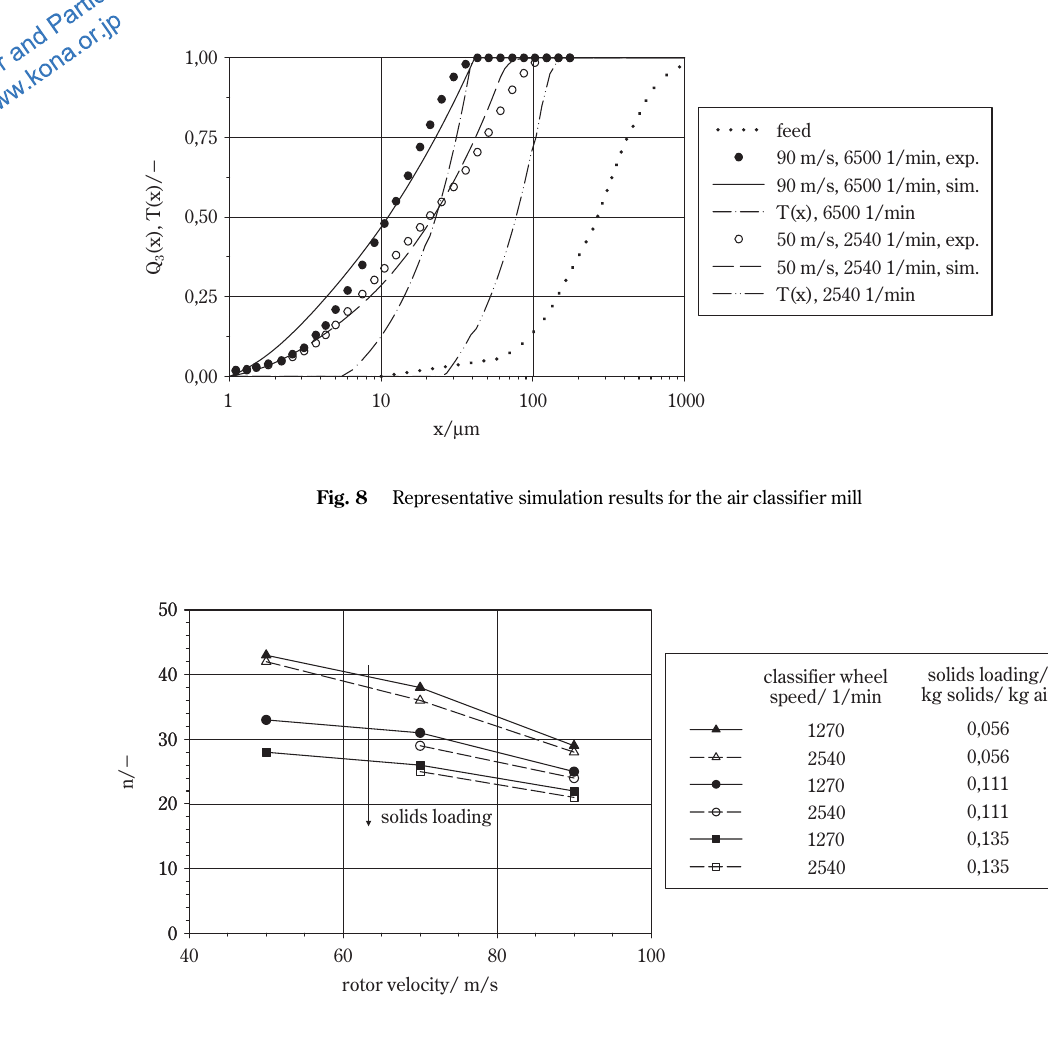
Fig. 9 Influence of the grinding rotor velocity on model